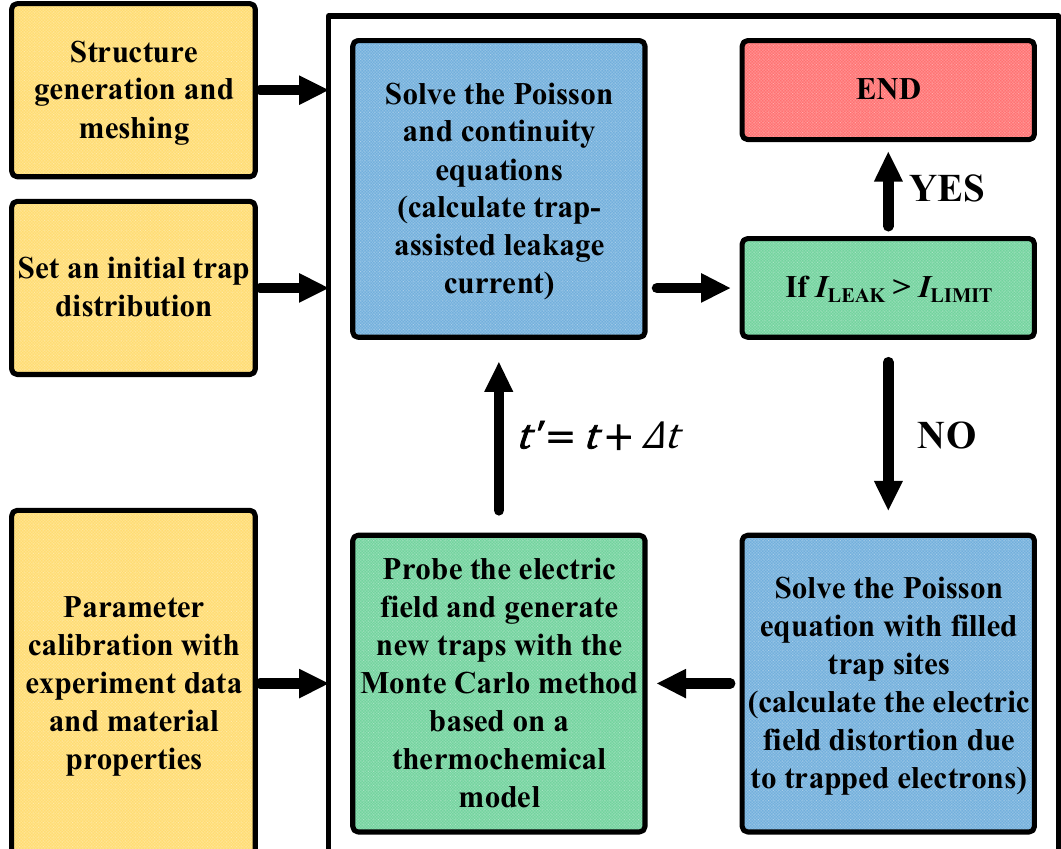
Figure 2. Flowchart of the proposed time-dependent dielectric breakdown (TDDB) model.